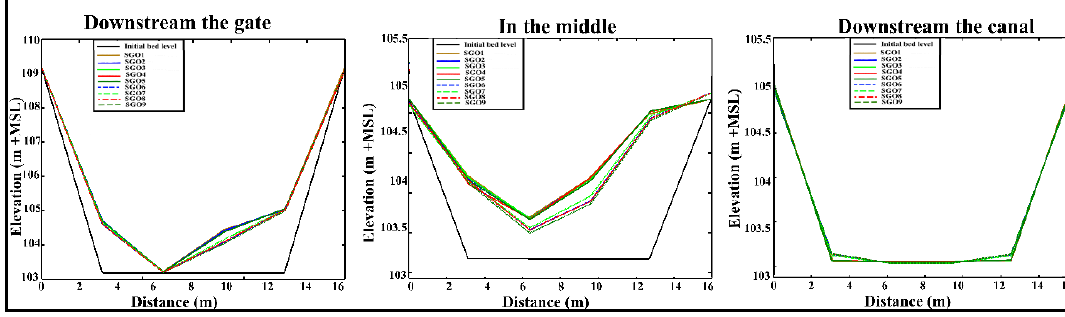
Figure 14. The bed level within cross-section in different scenarios.